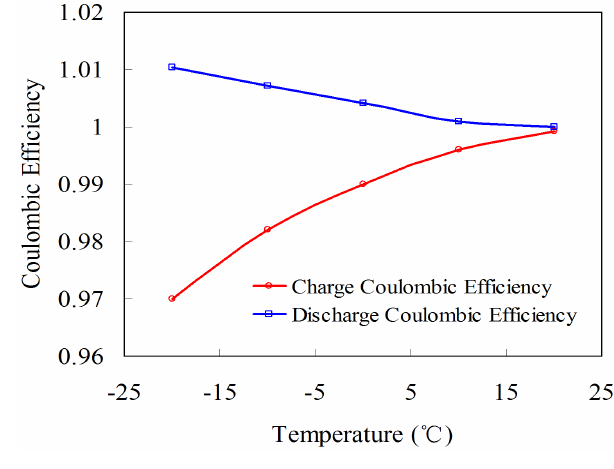
η at different , R R I T